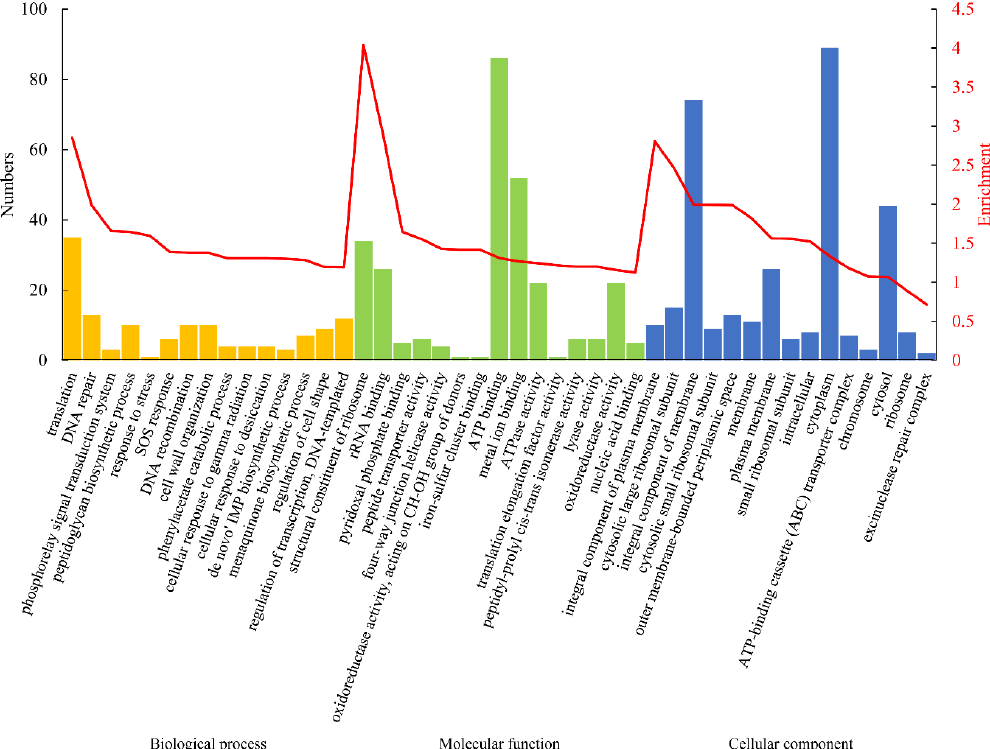
Figure 4. Gene ontology (GO) enrichment analysis of differentially expressed proteins between DC (control samples) and DH (treated samples). The vertical histogram represents the number of differential proteins enriched in each GO term; the red line represents the enrichment degree (−log 10 p value) of each GO term. The 45 most enriched GO terms are shown.